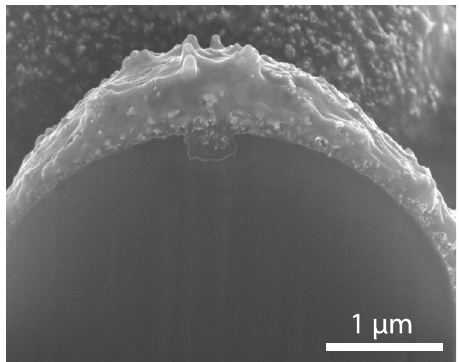
Fig. 6 SEM image of microparticle cross-section. SEM image of microparticle cross-section of a single silver coated melamine formaldehyde microparticle including a scale bar. The cross-section is obtained by cutting the microparticle with a gallium focused ion beam (FIB). Due to the rounded beam pro fi le of the FIB, the top part of the particle is rounded to a larger extent than the sides of the particle, which causes the coating layer to appear thicker at